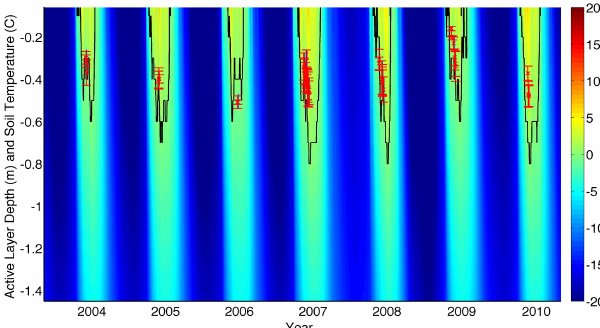
Figure 3. Soil temperature and active layer depth produced by Peatland-VU, tundra wet group TW1, 2004 to 2010. The red ver- tical lines toward the top of the figure indicate the measured active layer thickness, while the length of the line indicates one standard deviation. The black lines show the modelled active layer bound-